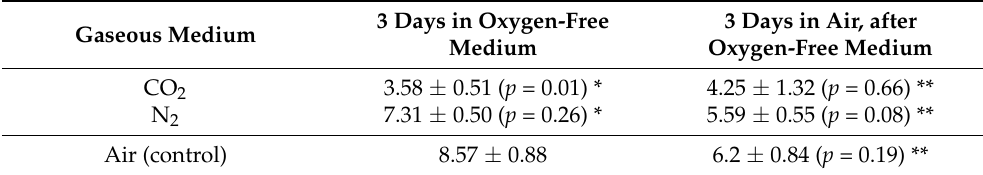
Table 6. Growth rate (mm/day) of dikaryotic mycelium Daedaleopsis septentrionalis on wort agar in oxygen-free and air media, n = 3.